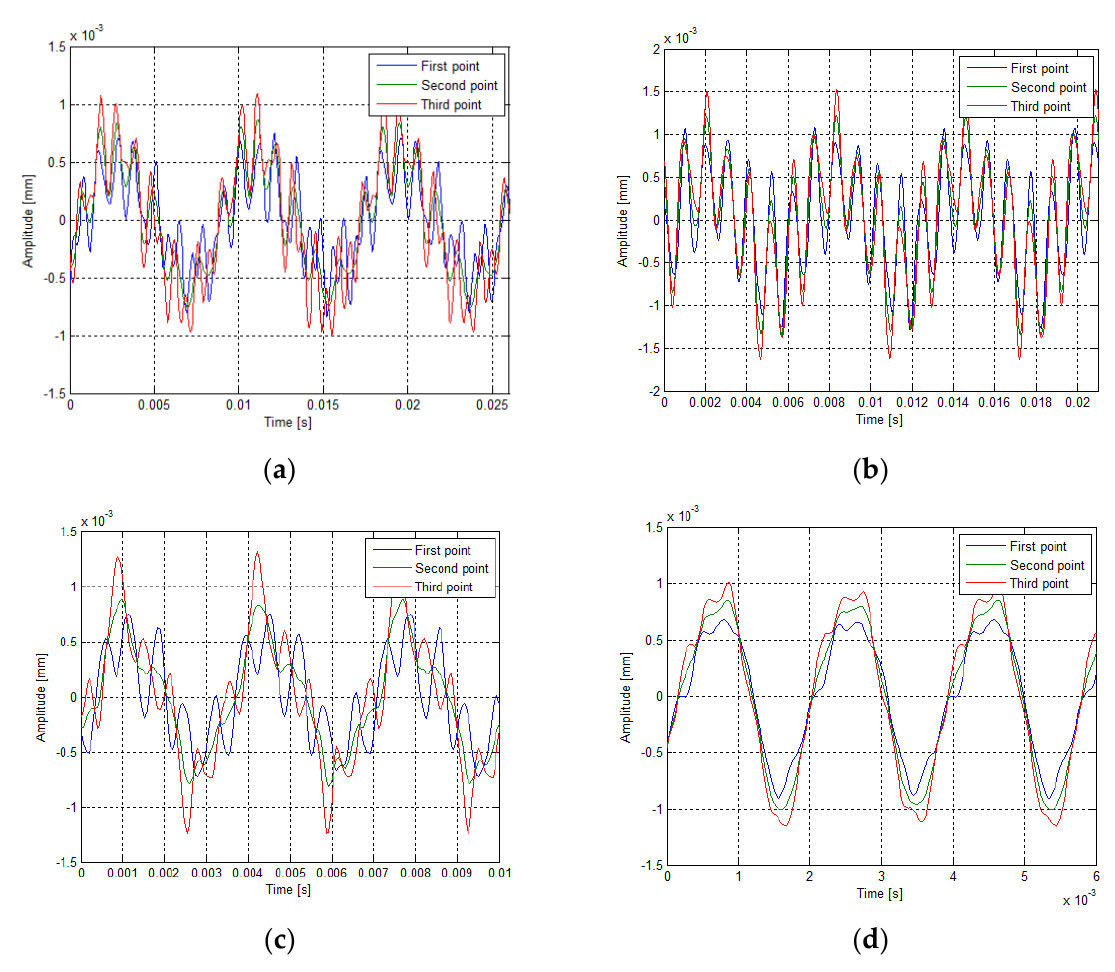
Figure 6. Vibrations of stator’s structure measured in three points for machine with skewed rotor: ( a ) 1800 rpm; ( b ) 2400 rpm; ( c ) 4500 rpm; and ( d ) 8000 rpm . ( a ) 1800 rpm; ( b ) 2400 rpm; ( c ) 4500 rpm; and ( d ) 8000